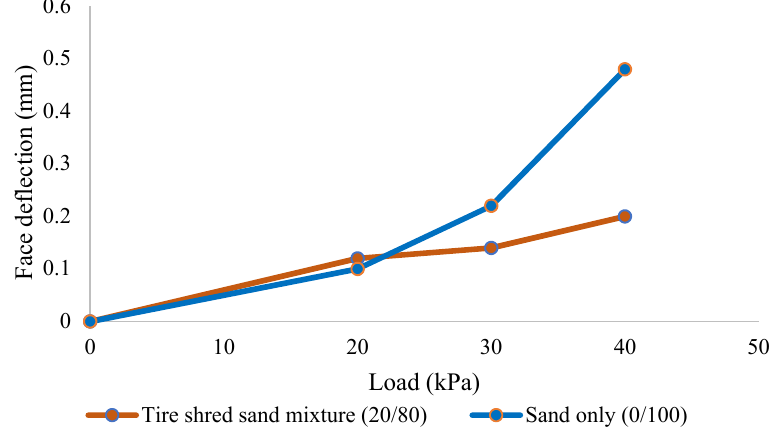
Figure 12. Comparison of face deflection for sand only (0/100) and tire shred-sand mixture (20/80) in Plaxis 3D.